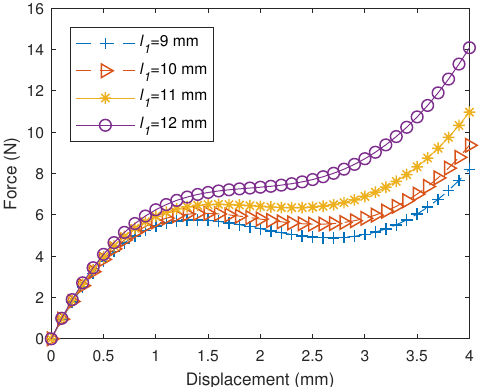
Figure 4. The force-displacement relationship of the CCFM along x